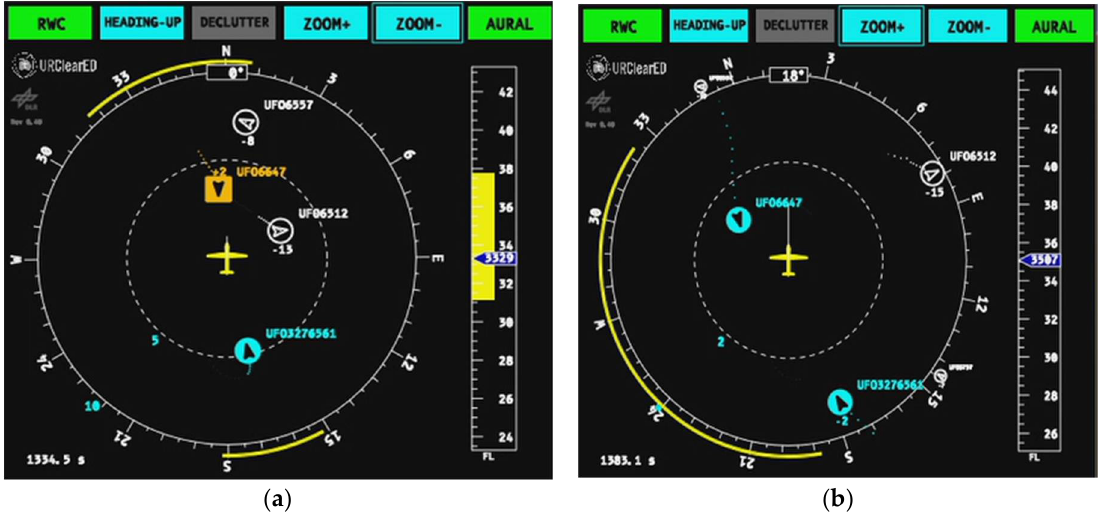
Figure 20. The CDTI before ( a ) and after ( b ) the Remain Well Clear maneuver.